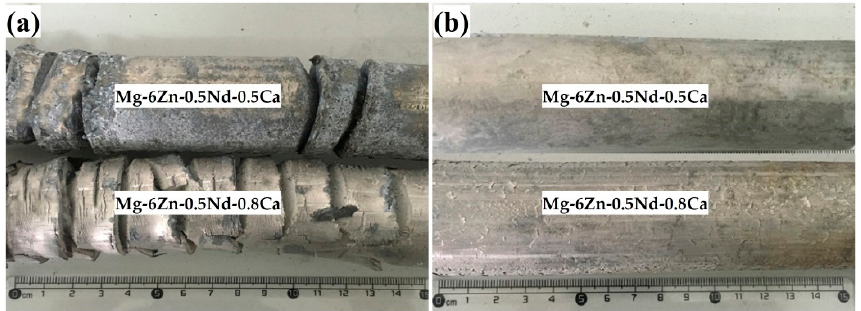
Figure 2. Appearance of the as-extruded Mg-6Zn-0.5Nd-0.5/0.8Ca alloys: ( a ) at high extrusion temperature; and ( b ) at medium extrusion